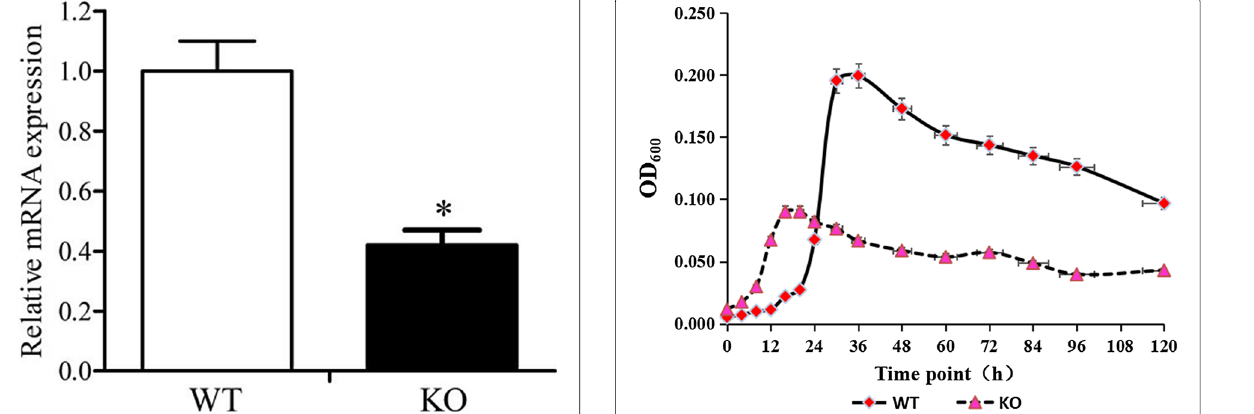
Fig. 1 The differences of mRNA expression (mean and SD) of cofD in WT and KO M. ruminantium . Strains were incubated at 30° C for 72 h. SD standard deviation, WT wild-type, KO knock-out. The asterisk (*) indicates a significant difference ( P < 0.05)